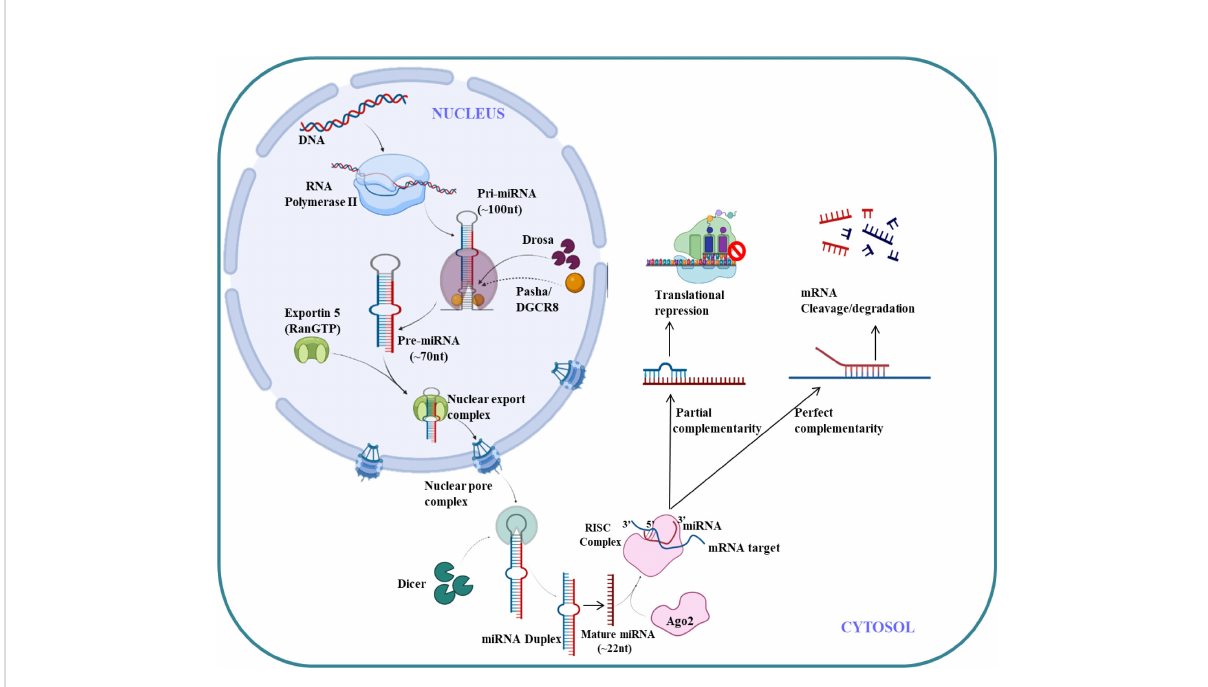
FIGURE 4 miRNA biogenesis and